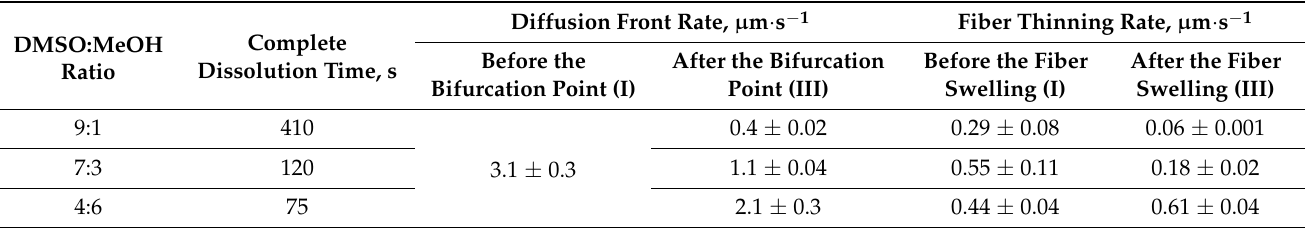
Table 2. Fiber dissolution rates in various